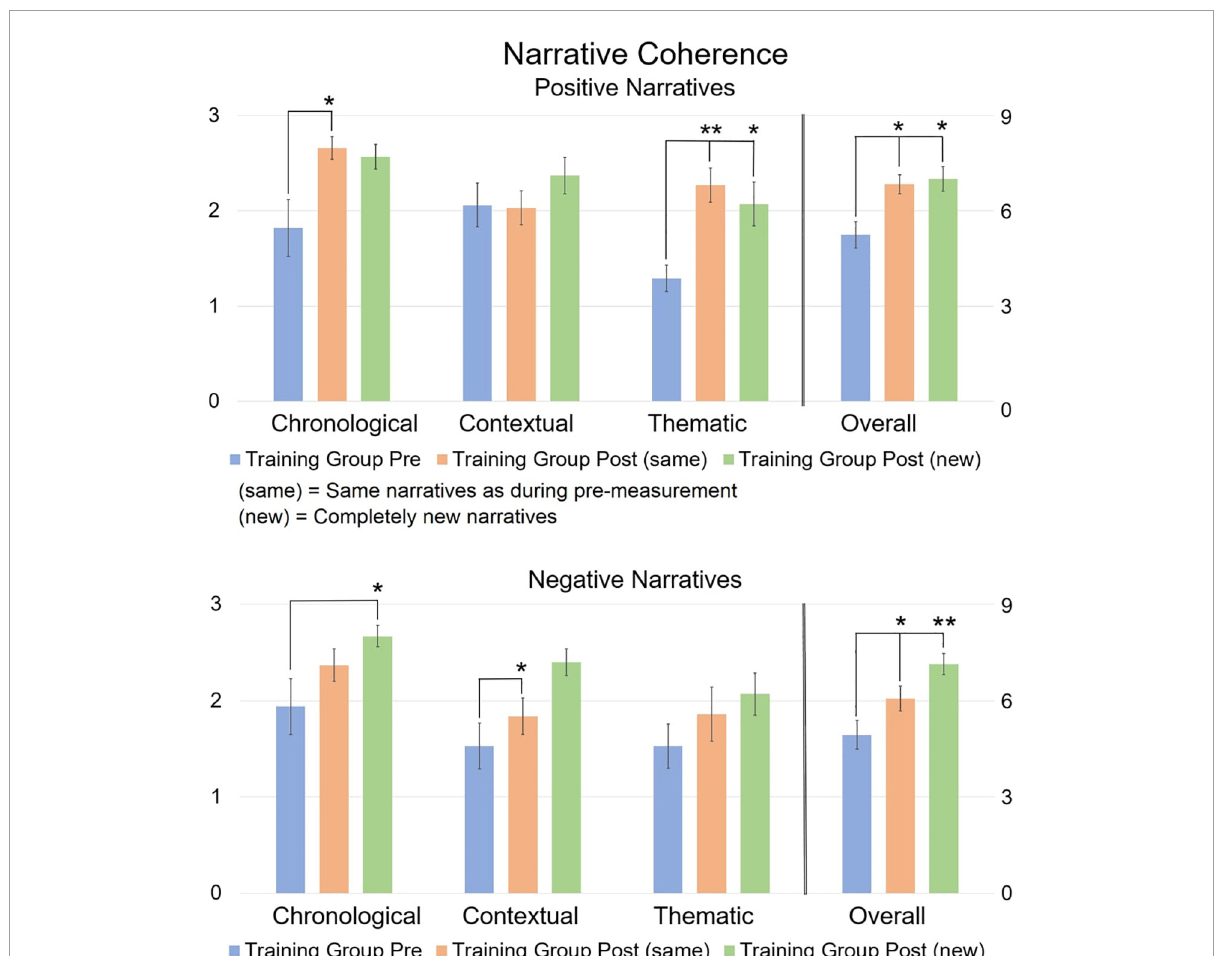
FIGURE3 Mean narrative coherence scores comparing pre and post scores. The 0–3 scale on the left refers to the three distinct coherence dimensions, while the 0–9 scale on the right refers to the overall coherence. The post-measurement refers to narratives that are the “same” or “new” compared to the pre-measurement. Error bars represent the Standard Error of Means (SEM). * p < 0.05, ** p < 0.001 F -test between pre- and post-measurement. Asterisks refer to the comparison between pre vs. post (new) and between pre vs. post (same), and not between post (new) and post